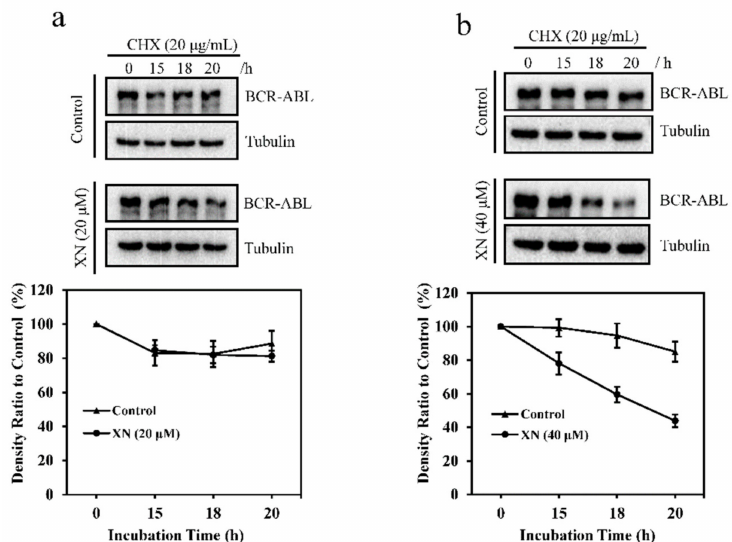
Figure 3. XN a ff ects BCR-ABL protein stability. K562 cells were incubated with cychloheximide (CHX, 20 µ g / mL) in the absence or presence of 20 ( a ) and 40 µ M XN ( b ) for 0–20 h. Then the cells were harvested and BCR-ABL levels were examined by Western blotting, and the relative density of BCR-ABL was analyzed and shown as histograms. Data are presented as mean ± SD for three independent